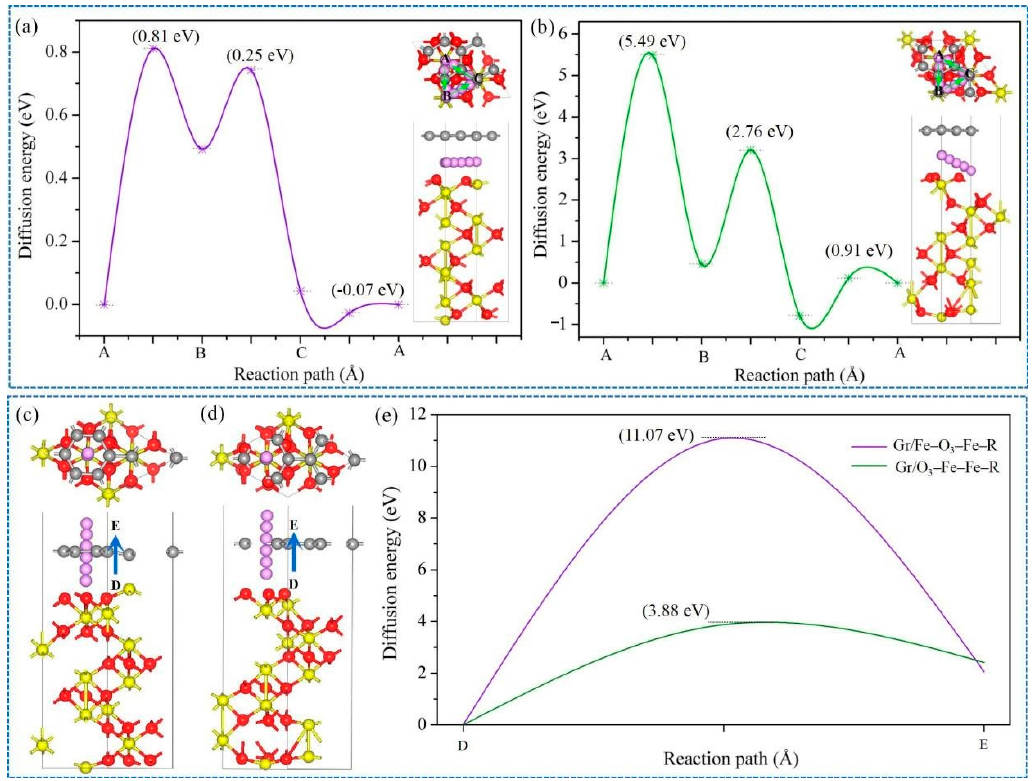
Figure 5. ( a , b ) Diffusion energy barrier profiles of A → B, B → C, and C → A in Gr/Fe-O 3 -Fe-R and Gr/O 3 -Fe-Fe-R systems. Insets in a and b show the schematical illustration of the migration pathways; ( c – e ) diffusion paths and the energy barriers of D → E for Gr/Fe-O 3 -Fe-R and Gr/O 3 -Fe-Fe-R